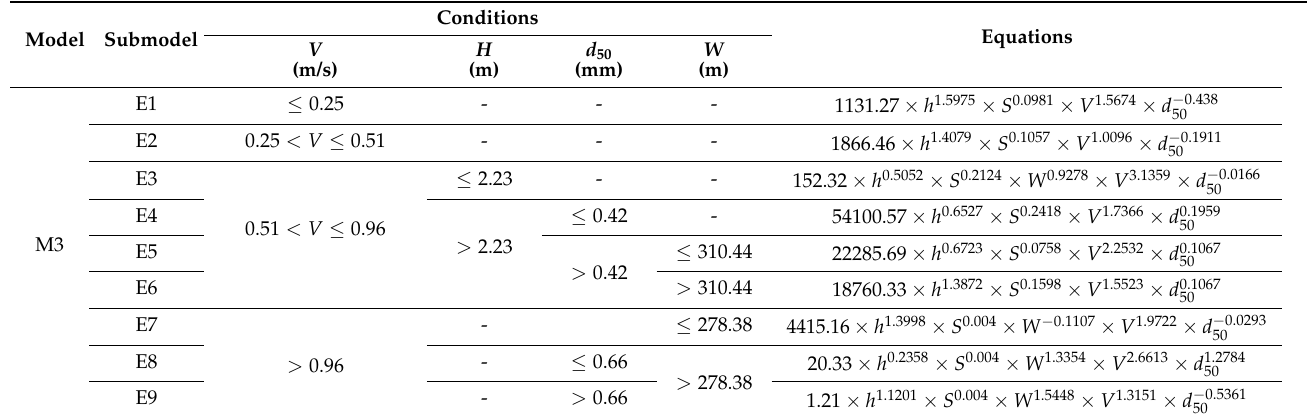
Table 3. Application conditions and determination coefficients of model 3 (M 3).